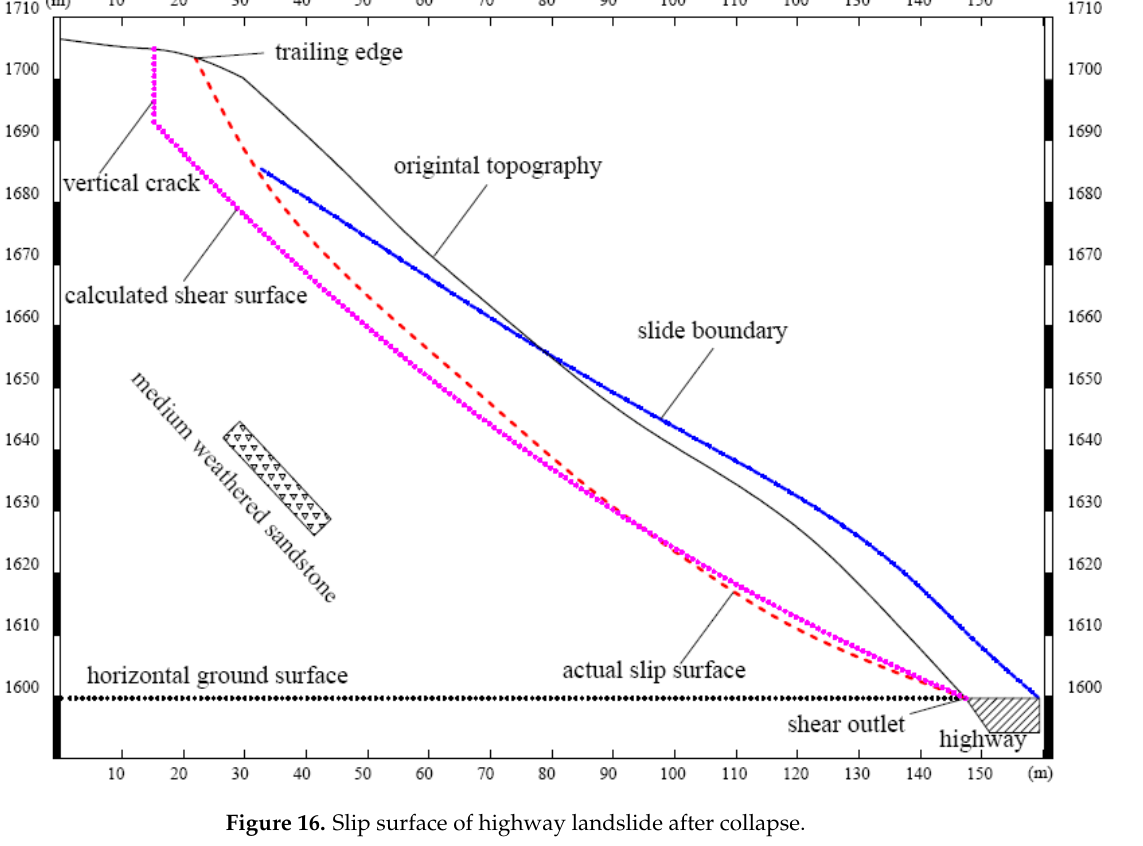
Figure 16. Slip surface of highway landslide after